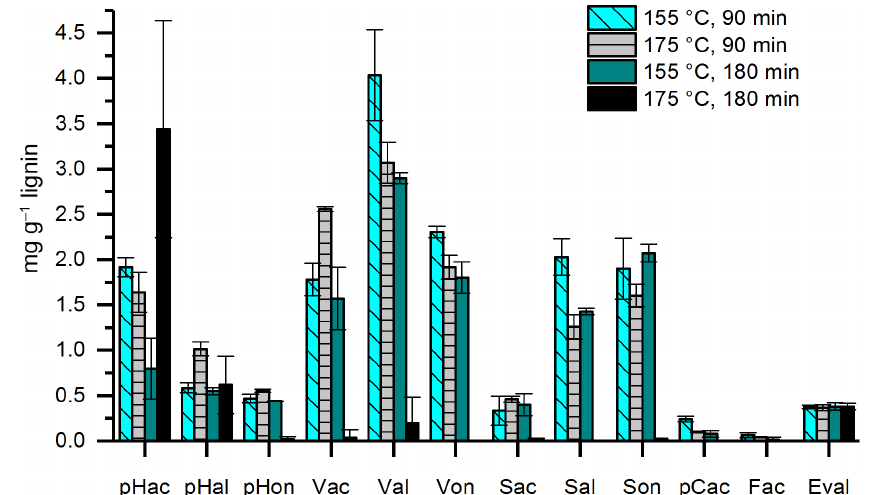
Figure 4. Results of a CuO oxidation step at 155 ◦ C and 90min (light blue bars with diagonal stripes), 175 ◦ C and 90min (grey bars with horizontal stripes), 155 ◦ C and 180min (dark cyan bars), and 175 ◦ C and 180min (black bars). Eval was added after the CuO oxidation step as an internal